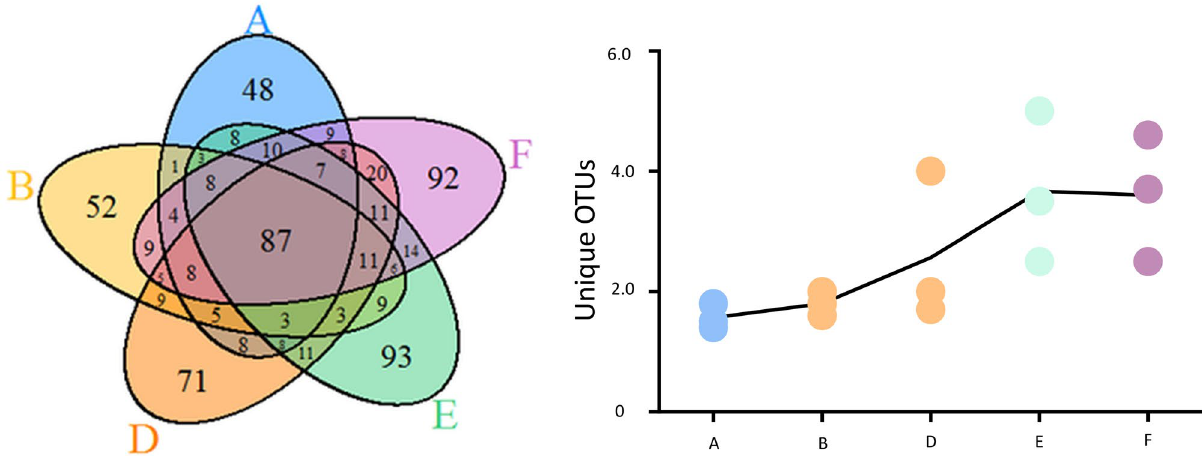
Figure 2. Venn diagram showing the number of shared and unique OTUs among differently sized seed samples (A = 100, B = 200; D = 600, E = 800; F = 1000 seeds) (left) and the unique OTUs abundance for each replicate of different samples